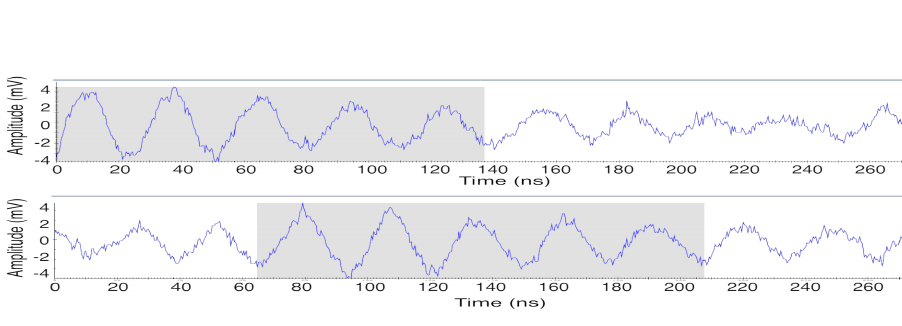
Figure 25: The selected part for alignment the protected and unprotected implementation